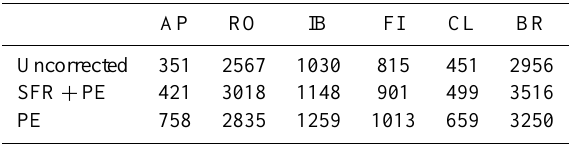
Table 1. Comparison between uncorrected MODIS data, sole use of proportional extrapolation (PE; Preußer et al., 2015) and a com- bined step-wise approach using both, spatial feature reconstruction (SFR; Paul et al., 2015a), and proportional extrapolation. Values are presented for each of the six subregions (Fig. 1) and based on their multi-year average polynya area [km 2 ].